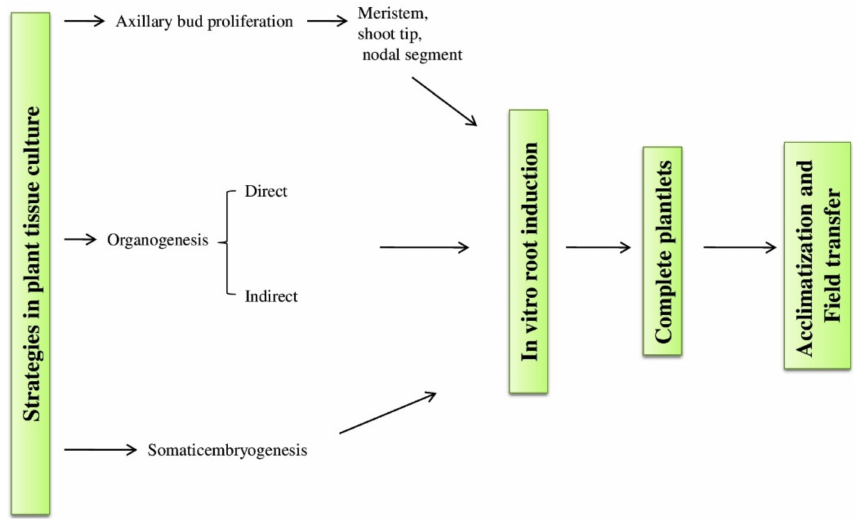
Figure 2. Strategies in the plant tissue culture for the in vitro propagation of the genus Decalepis .